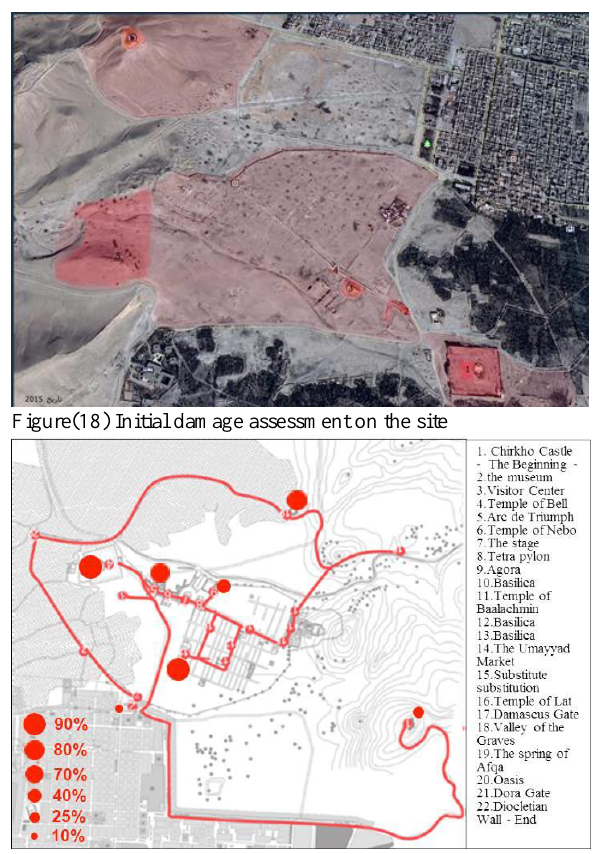
Figure (19) Assessment Scheme for the damaged & destructed